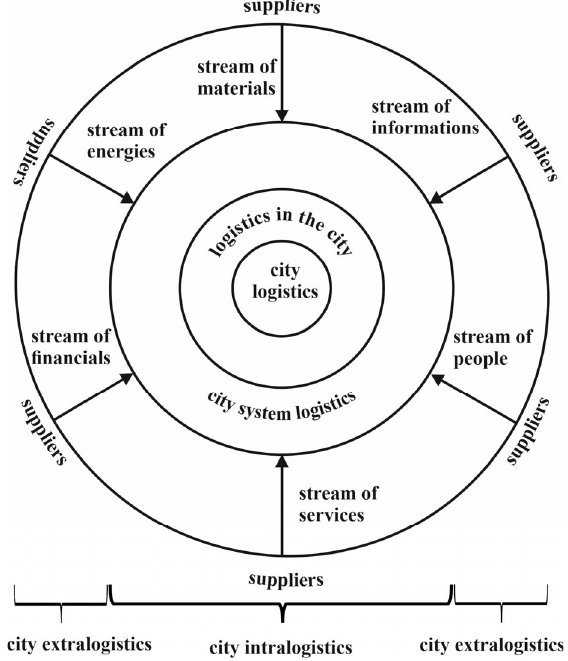
Figure 1. Central location of City Logistics in a holistic view of the City’s Logistics System. Source: Own study.